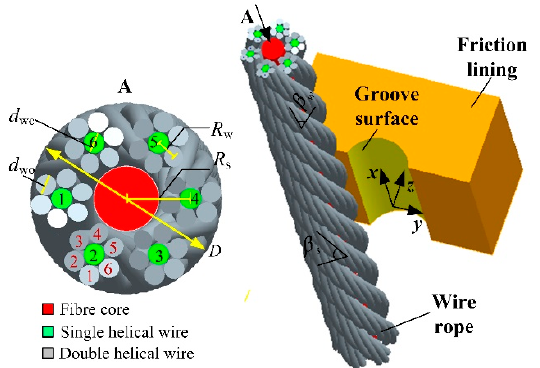
Figure 1. Schematic of a wire rope and simplified model of a friction lining-wire rope contact, quoted from [3].